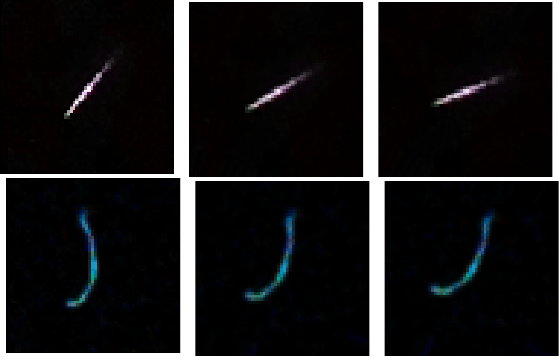
Figure 7. Original track ( upper row ) and worm ( lower row ) and their augmented